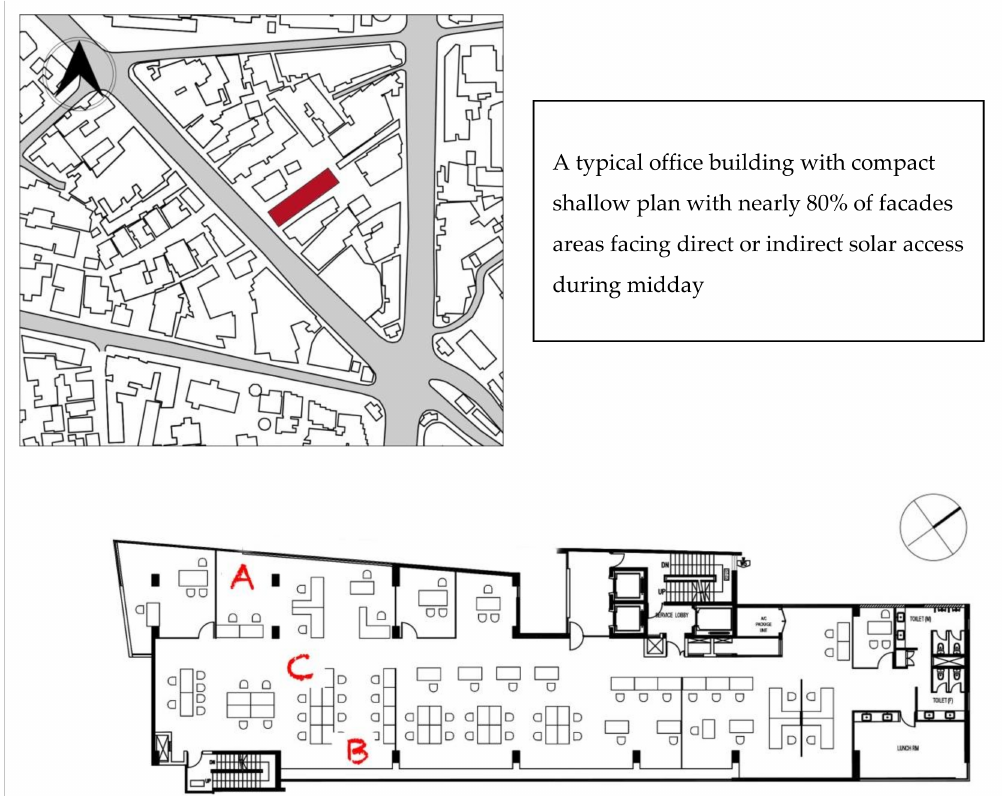
Figure 3. Building A (plan depth—14 m, length—56 m) shallow plan forms with unprotected façades contributes to heat stress from environmental